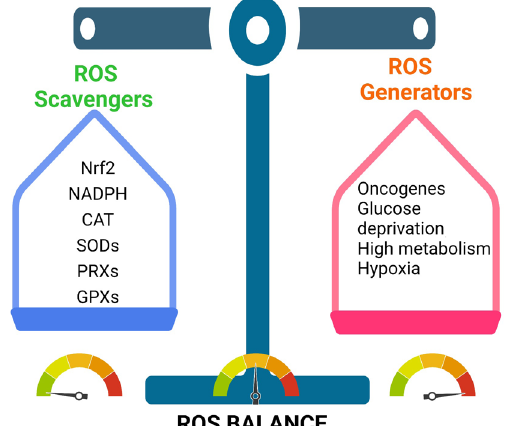
Figure 2. Cancer cells maintain their tumorigenic ROS levels by balancing ROS production and scavenging. This enables them to stay inside the tumorigenic range. CAT: